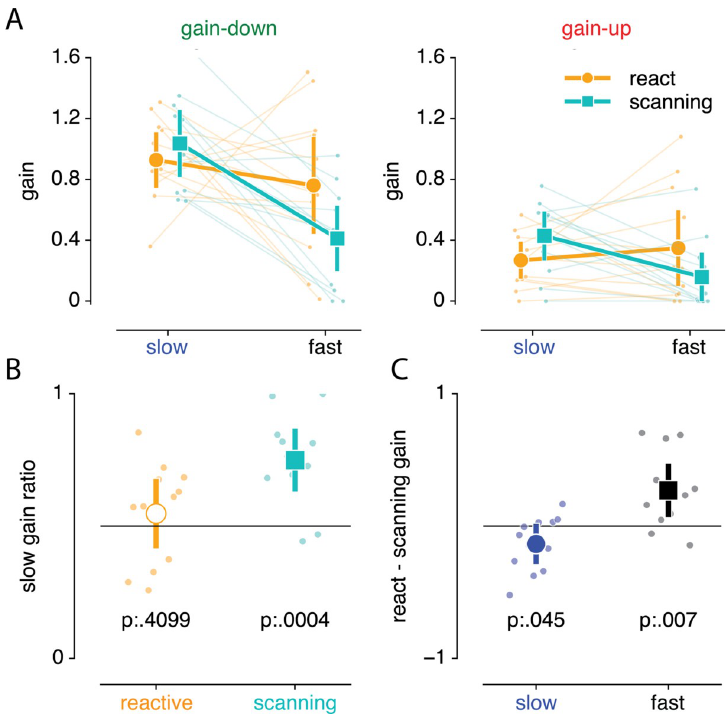
Fig 6. Quantification of dual process contribution to reactive and scanning saccades. (A) Comparison of process gain in both saccade type (reactive and scanning) and direction (gain-up and gain-down) blocks. (B) Contribution of slow process to overall adaptation averaged over gain-down and gain-up blocks for reactive and scanning blocks separately. This shows that reactive saccades are equally driven by the fast and slow process, whereas scanning saccades are driven mainly by the slow process. (C) Reactive minus scanning process gain averaged over gain-up and gain-down blocks for the slow and fast process separately. This shows that the slow process is stronger in scanning compared to reactive saccades, while the fast process is stronger in reactive compared to scanning saccades. Error bars depict 95% CI over participants. Individual dots and lines indicate individual participants. parameters over the course of the experiment. The change in these parameters is expressed in gain relative to the baseline block, in identical fashion to the results on saccade amplitude in Fig 3. Visual inspection of this figure illustrates that gain-down, but not gain-up adaptation is driven mainly by changes in peak velocity, in both reactive and scanning saccades. To quantify this, we computed the median saccade amplitude, velocity and duration change over the last 16 trials in the first adaptation block (Fig 7C). This analysis shows that absolute saccade ampli- tude change was stronger in gain-down compared to gain-up adaptation (0.109 vs 0.059 respectively, main effect of direction F = 21.604, p = 7.074 � 10 − 4 , η 2 p = .627), but that sac- (1,11) cade amplitude change was not different between reactive and scanning saccade adaptation (0.084 vs 0.083 respectively, main effect of condition F = 0.021, p = .888, η 2 p = 1.980 � (1,11) 10 − 4 , interaction between condition and direction, F = 0.932, p = .355, η 2 p = .008). To test (1,11) the extent to which adaptation was driven by changes in peak velocity and duration, we set up two separate ANOVAs (one for gain-up and one for gain-down adaptation) with the factors of saccade parameter (2 levels: velocity or duration) and saccade type (2 levels: reactive or scan- ning). This showed that peak velocity change was greater than duration change during gain- down adaptation (-0.037 vs -0.008 respectively, main effect of saccade parameter F = (1,11) 31.660, p = 1.541 � 10 − 4 , η 2 p = .385), but not during gain-up adaptation (0.007 vs 0.011 respec- tively, main effect of saccade parameter F = 0.195, p = .667, η 2 p = .003). This shows that (1,11)